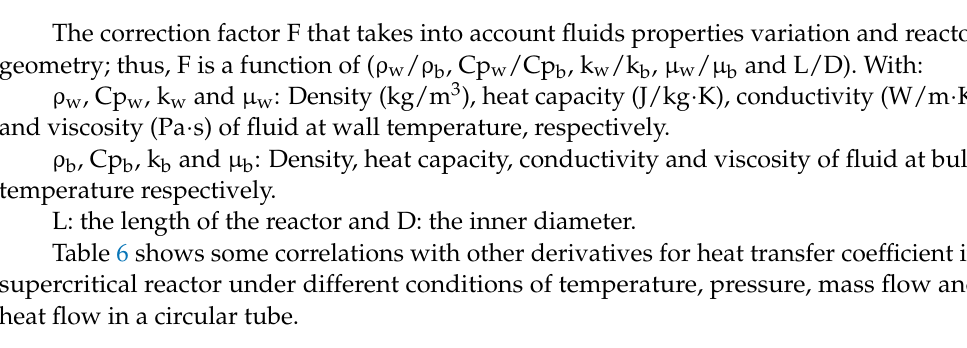
Table 6. Selected correlations for heat transfer in supercritical reactors